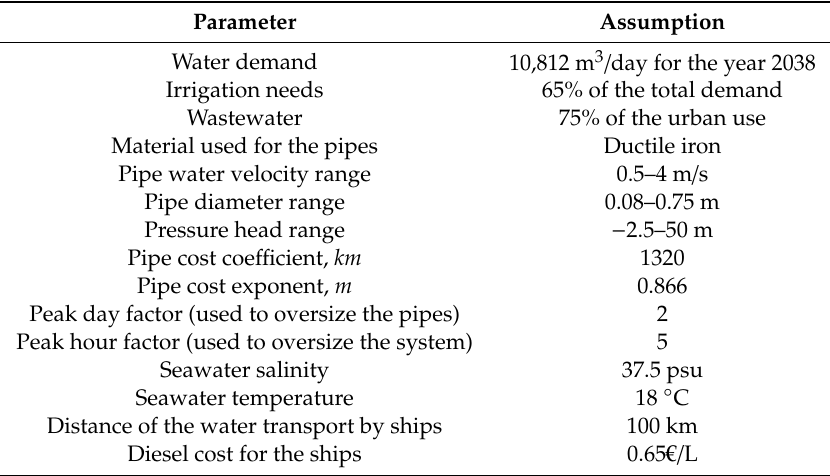
Table 2. General assumptions for cost